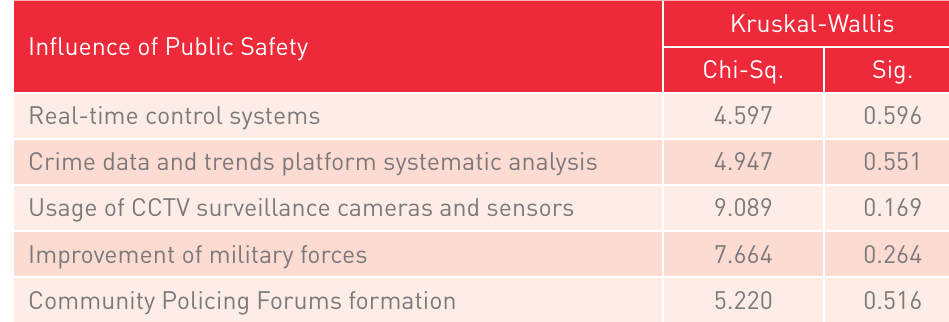
Kruskal-Wallis H-Test for Influence of Public Safety on Resilience Influence of Public